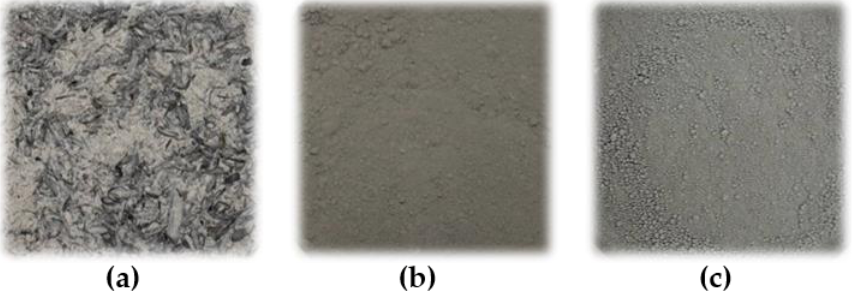
Figure 1. Waste used to replace Portland cement ( a ) eucalyptus biomass ash (EBA) before grinding ( b ) EBA after grinding and ( c ) silica fume. Table 1. Chemical composition of EBA and silica fume (SF).